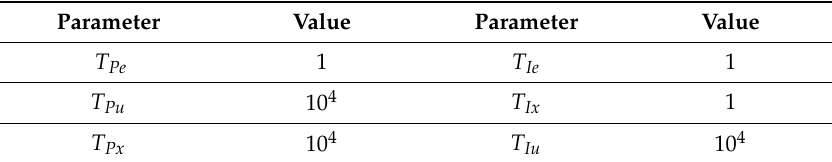
Table 4. Weights for the adaptive